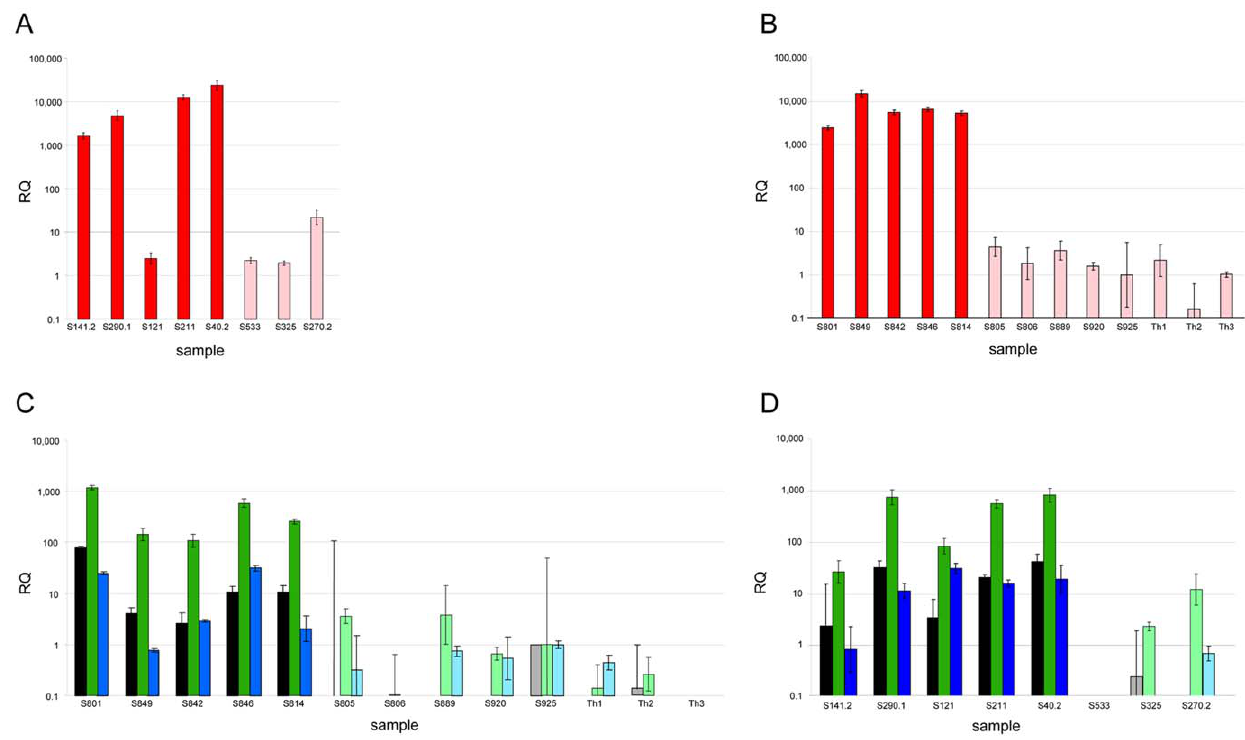
Figure 3. Expression of miR-520c, miR-371-3p, miR-372 and miR-373 in cell lines and primary tumors. Relative expression of miRNAs was determined by real-time PCR (mean s.d. from three independent experiments). Values of miRNA were normalized to RNU6B (RNA, U6 small nuclear 2) ( A ) miR-520c expression in thyroid cell lines, five cell lines derived from adenomas with 19q13.4 rearrangements (S141.2, S290.1, S121, S211, S40.2) (red bars) and three cell lines derived from thyroid adenomas with other structural rearrangements (S533, S325, S270.2) (light red bars). ( B ) miR-520c expression in three samples of non-neoplastic thyroid tissues (Th1, Th2, Th3) (light red bars), five adenomas with 19q13.4 rearrangement (S801, S849, S842, S846, S814) (red bars) and five adenomas without cytogenetically detectable aberrations (S805, S806, S889, S920, S925) (light red bars). ( C ) miR-371-3 expression in three samples of non-neoplastic thyroid tissues (gray (miR-371-3p), light green (miR-372) and light blue (miR-373)), five adenomas with 19q13.4 rearrangement (black (miR-371-3p), green (miR-372) and blue (miR-373)) and five adenomas without cytogenetically detectable aberrations (gray, light green and light blue bars) (for case numbers refer to Table 1). ( D ) miR-371-3 expression in thyroid cell lines, five cell lines derived from adenomas with 19q13.4 rearrangements (black (miR-371-3p), green (miR-372) and blue (miR-373)) and three cell lines derived from thyroid adenomas with other structural rearrangements (gray (miR-371-3p), light green (miR-372) and light blue (miR-373)) (for case numbers refer to Table 1).